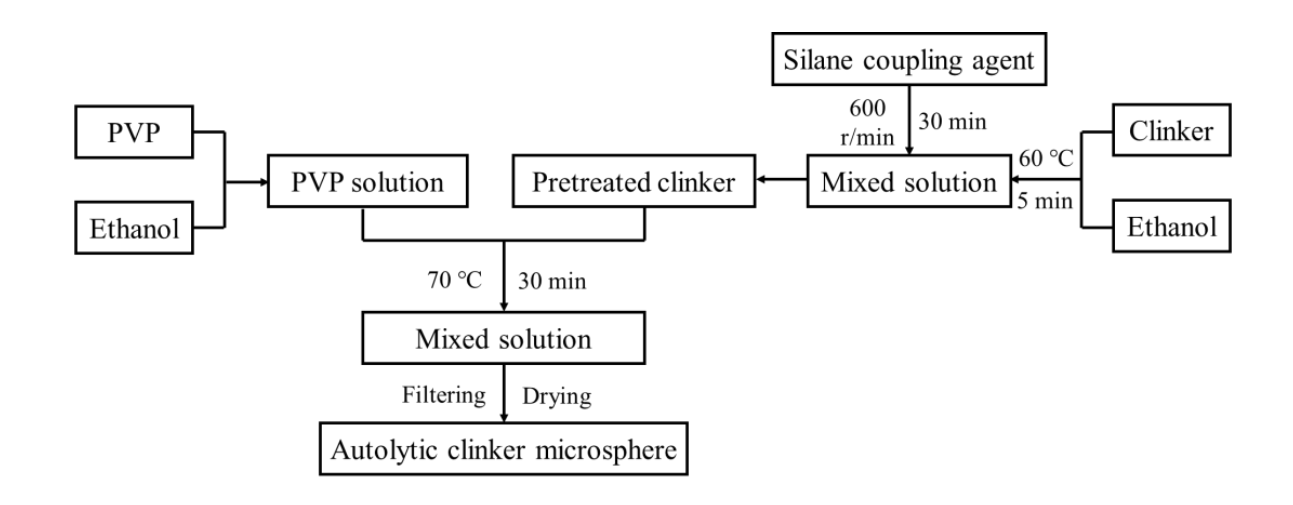
Figure 2. Schematic illustration of autolytic clinker microsphere preparation process.